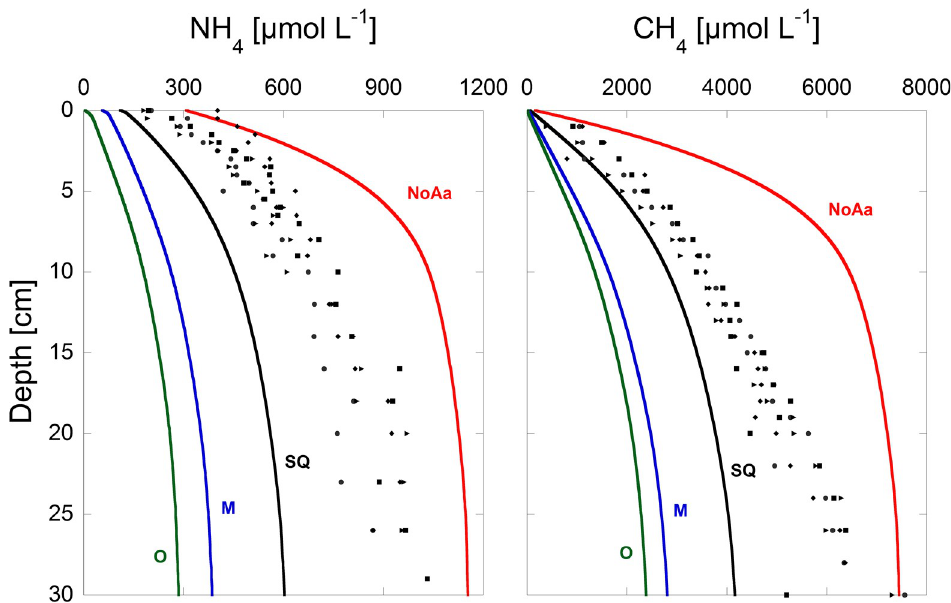
Fig 5. Modeled CH 4 and NH 4 porewater concentrations for the year 2050. The colored lines represent results for the different scenarios: red (no artificial aeration), black (status quo), blue (mesotrophic) and green (oligotrophic). In comparison, the porewater concentrations measured in the year 2015 are plotted with black dots.